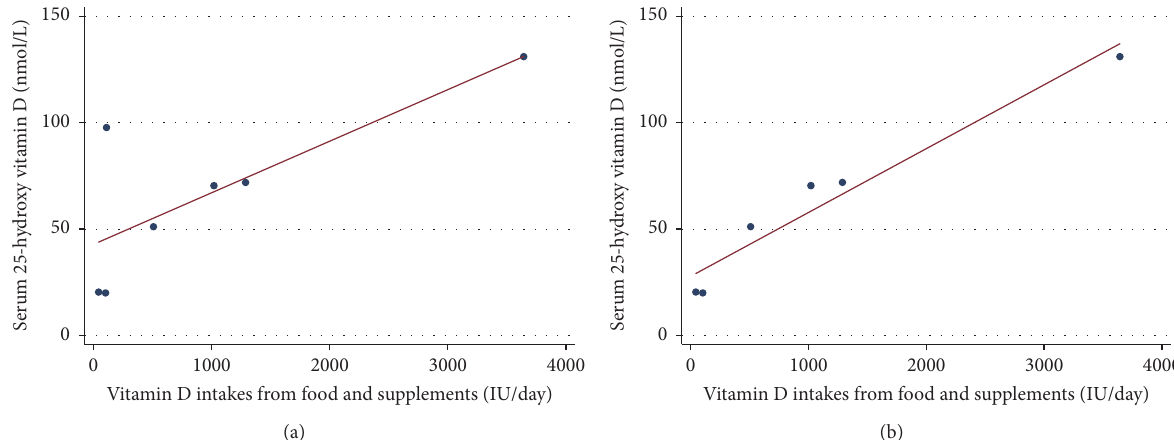
Figure 1: (a) Association between vitamin D intakes and status. Serum 25(OH)D levels increased by 2.4 nmol for every 100IU of vitamin D intake (95% Confidence interval = 1.2–4.7, adjusted 𝑅 2 = 0.512, and 𝑝 = 0.043 ). (b) Association between vitamin D intake and status without outlier. Without this outlier, serum 25(OH)D levels increased by 3.6nmol for every 100IU of vitamin D intake (95% Confidence interval = 2.0–4.0, adjusted 𝑅 2 = 0.931, and 𝑝 = 0.001 ).